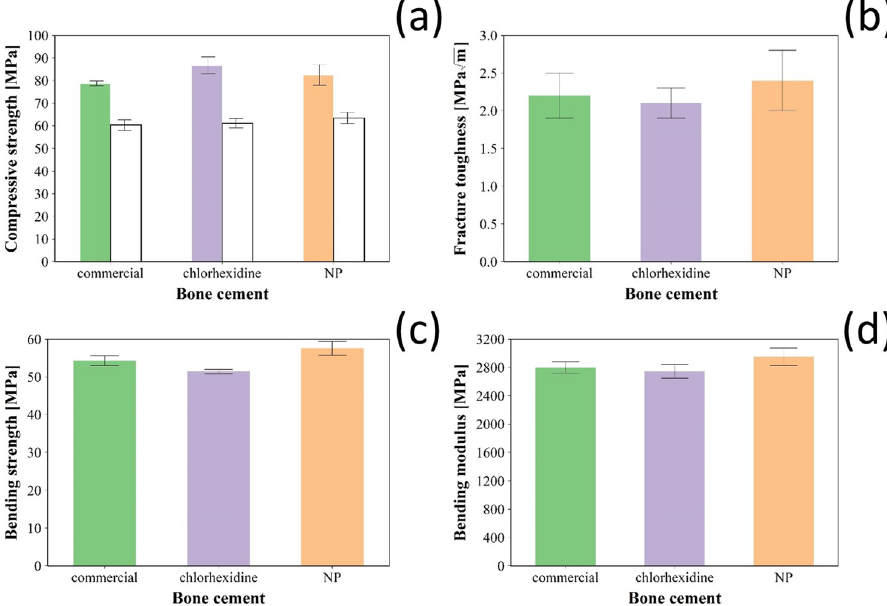
Fig 6. Mechanical properties of bone cement. (a) Compressive strength after settling (coloured bars) and after 3 months incubation in PBS (white bars); (b) fraction toughness, (c) bending strength and (d) bending modulus of Cemex 1 bone cement (green), Cemex 1 containing chlorhexidine powder 3% w/w (violet) and coated silica nanoparticles (orange) (mean ± SD, n = 6).